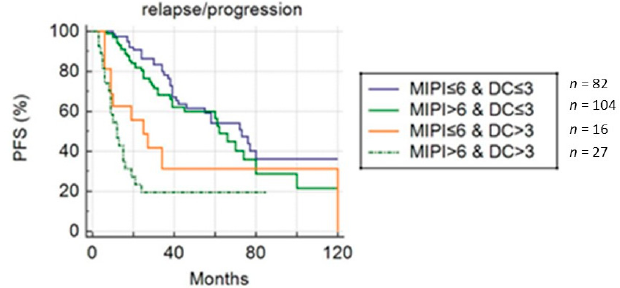
Figure 3. Progression-free survival (PFS) curves according to end-of-treatment PET/CT results using ( a ) Deauville criteria and ( b ) MIPI score.